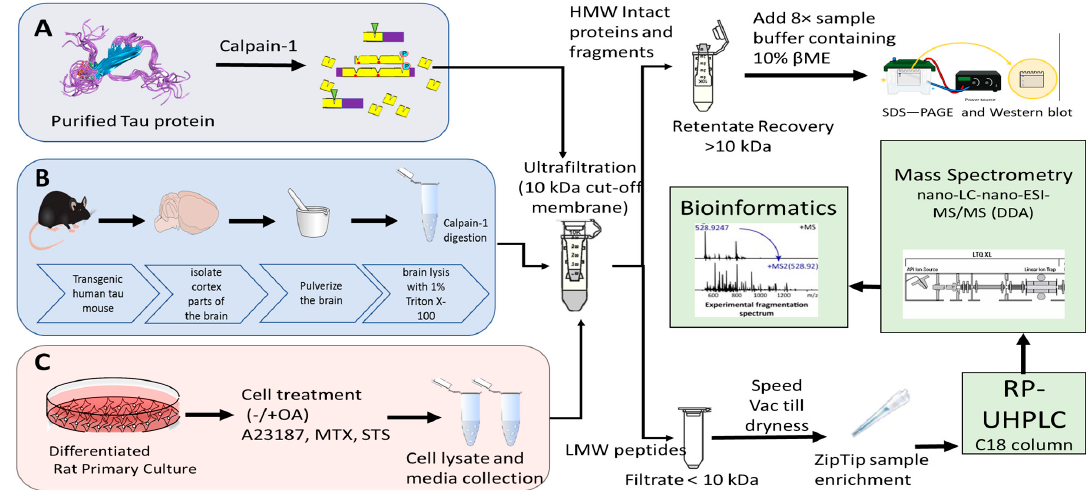
Figure 1. Peptidomic workflow for nano-liquid chromatography coupled to electrospray ionization and tandem mass spectrometry (nano-LC-ESI-MS / MS) for the analysis of purified Tau protein, rat di ff erentiated primary culture and mouse brain lysate. Subjecting the proteins to an in vitro calpain-1 digestion results in both high molecular weight (HMW) protein fragments and low molecular weight (LMW) proteolytic peptides production. HMW fragments were reduced